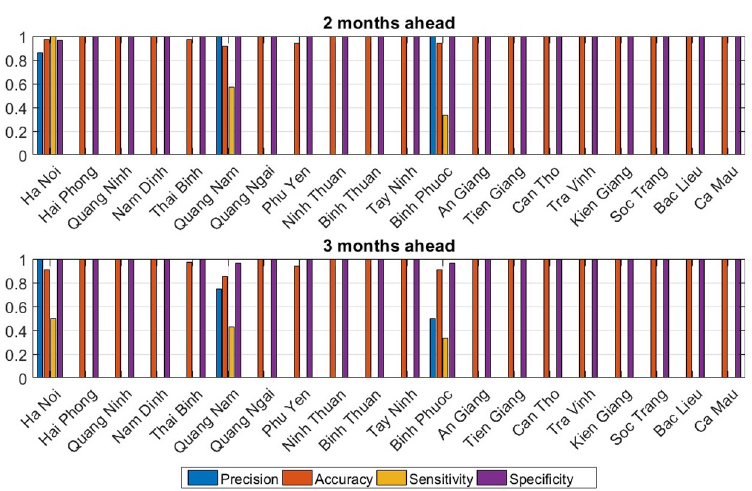
Fig 8. Precision, accuracy, sensitivity, and specificity for multi-step ahead epidemic prediction using LSTM-ATT. LSTM-ATT = attention mechanism-enhanced long short-term memory.